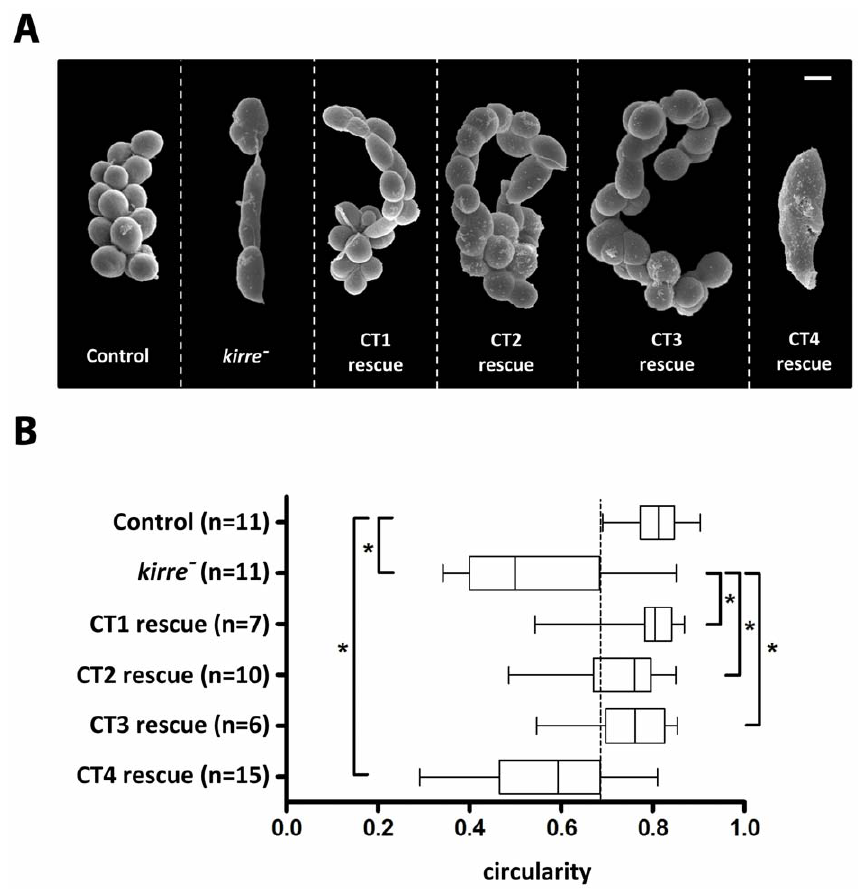
Figure 5. GCN fusion requires the cytoplasmic part of Kirre containing the KIN1 motif. A. Scanning electron micrographs of GCNs at third larval stage. Scale bar: 20 m m. B. Quantitation of GCN circularity revealing that Kirre versions CT1– CT3 which still contain the KIN1 motif are able to partially restore the wildtype situation. However, Kirre-CT4 missing the conserved KIN1 motif is not able to rescue the GCN fusion phenotype. *P value , 0,0001 (unpaired t-test with Welchs correction). Genotypes: Control: + /sns-GAL4 ; kirre - : Df(1)duf sps-1 ; CT1 rescue: Df(1)duf sps-1 /y; UAS-CT1/sns- GAL4 ; CT2 rescue: Df(1)duf sps-1 /y; UAS-CT2/sns-GAL4 ; CT3 rescue: Df(1)duf sps-1 /y; UAS-CT3/sns-GAL4, CT4 rescue: Df(1)duf sps-1 /y; UAS-CT4/sns-GAL4.